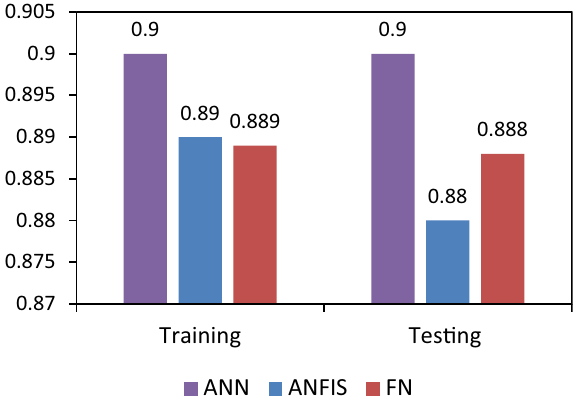
Figure 14. Coefficient of determination (R 2 ) comparison between the training and testing datasets of ANN, ANFIS and FN predictions